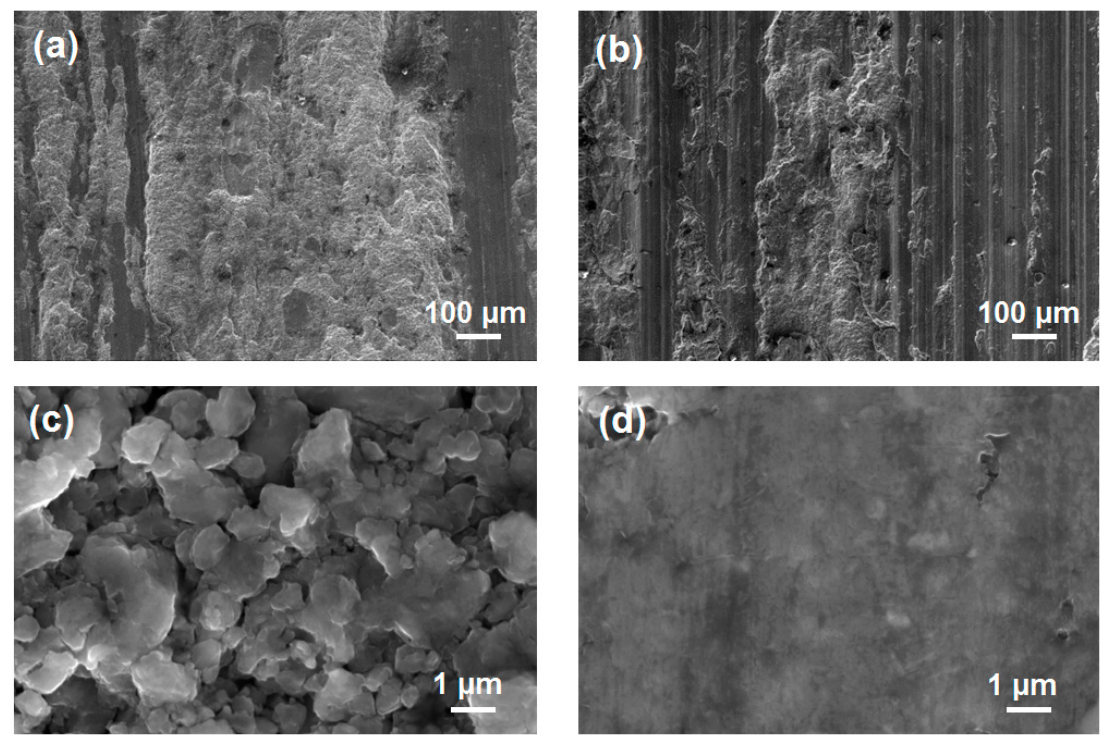
Figure 6. SEM images of the wear surfaces. ( a ) Wear surface aluminum alloy AA1050; ( b ) wear surface of the composite material GNS/AA1050; ( c ) valleys of the worn surface of the GNS/AA1050; ( d ) crests of the worn surface of the GNS/AA1050.